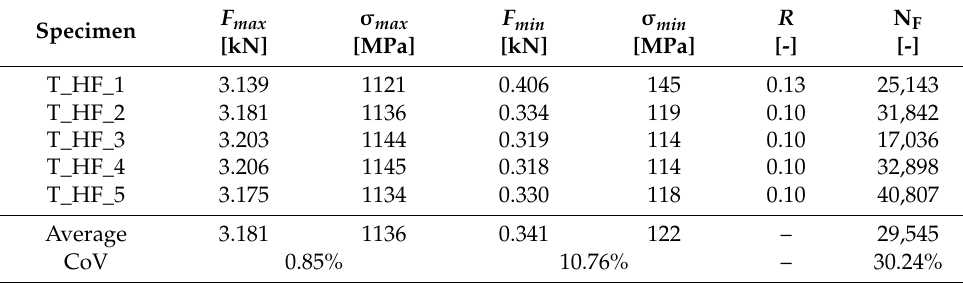
Figure 3. Stress (load)–strain response of specimen T_HF_2. Table 3. Results of high-cycle fatigue test.